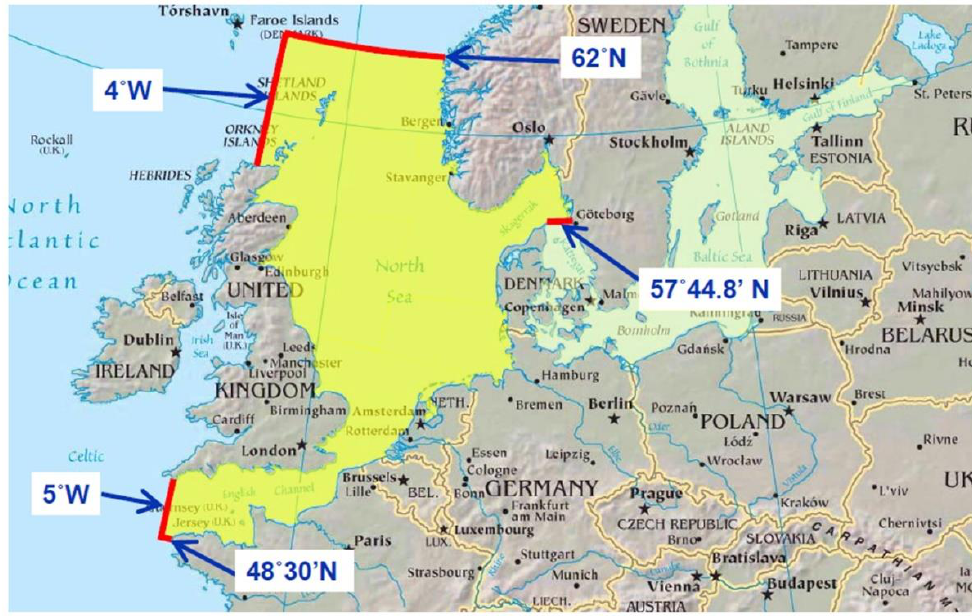
Figure 3. European special ecological regions.